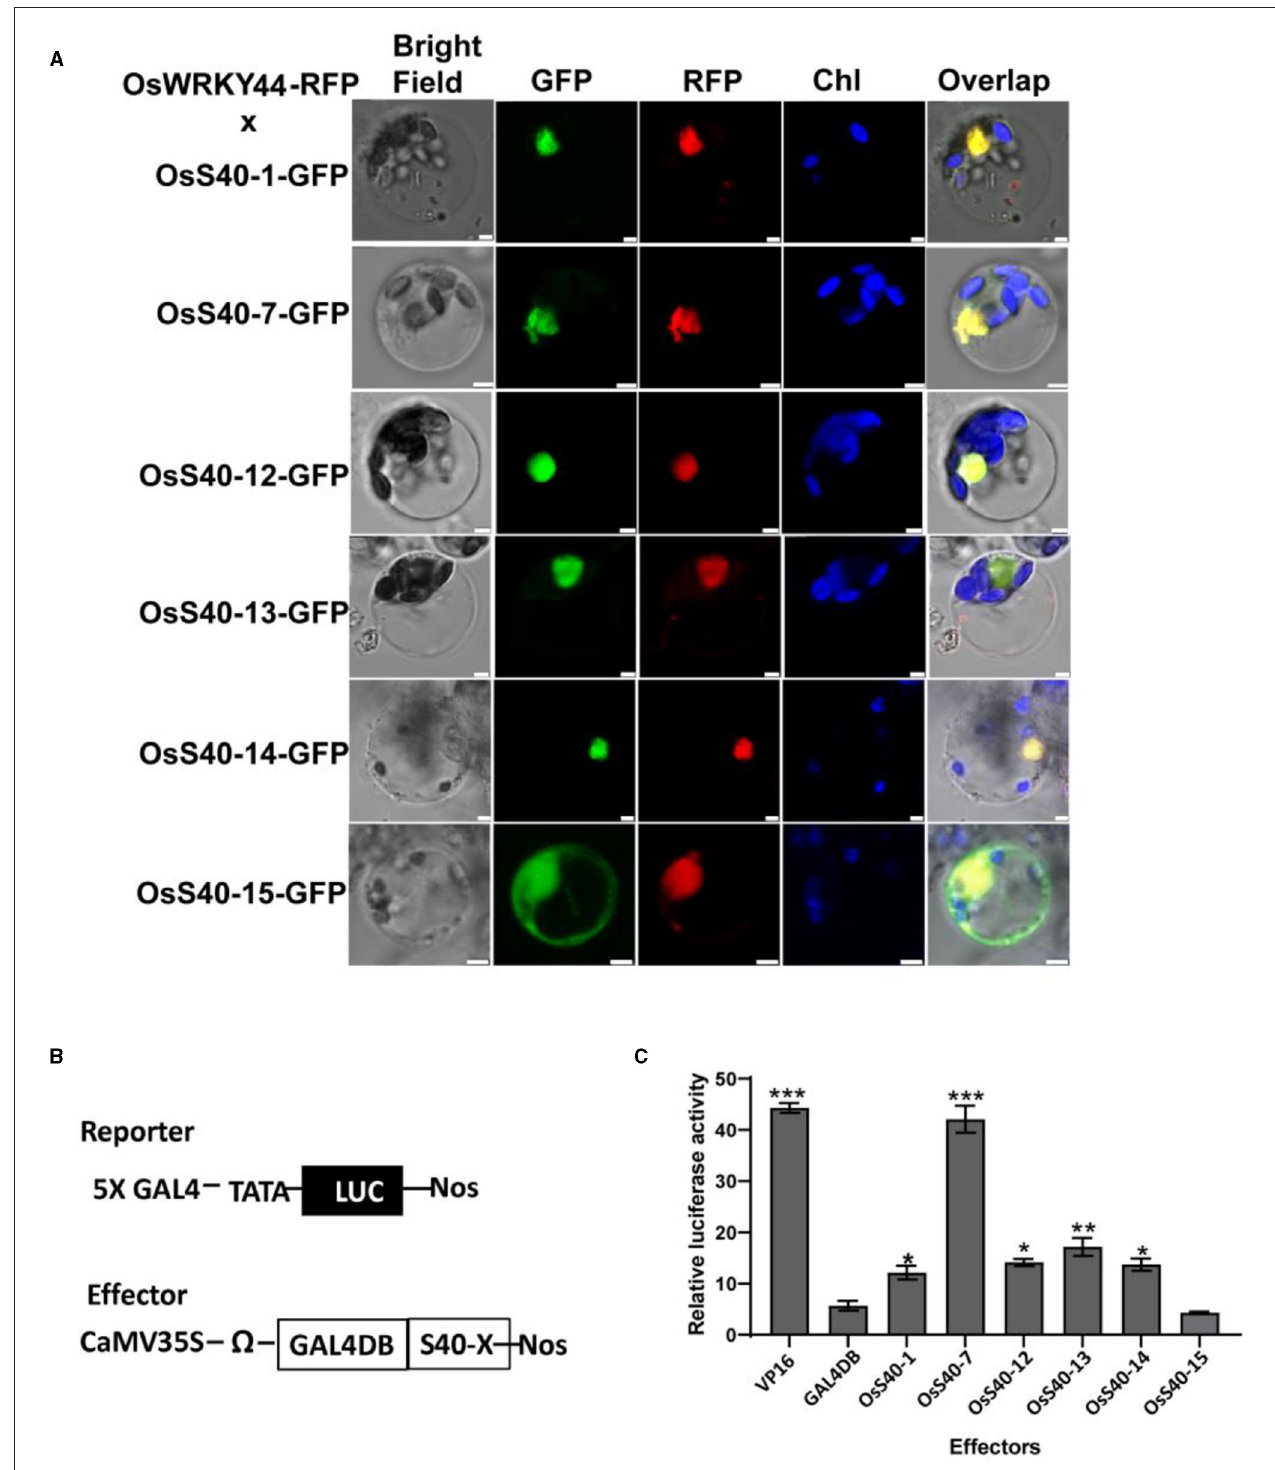
FIGURE 8 | Subcellular localization and transcriptional regulation activity of OsS40 . (A) Subcellular co-localization of OsS40 s-GFP and OsWRKY44-RFP proteins in rice protoplasts as revealed by green fluorescence and red fluorescence, respectively. Scale bar = 5 µ m (B) A scheme of reporter and effector constructs used in the transcriptional regulation assay. The GAL4-responsive reporter constructs, GAL4-LUC, containing five copies of the GAL4-binding site in tandem and a minimal TATA